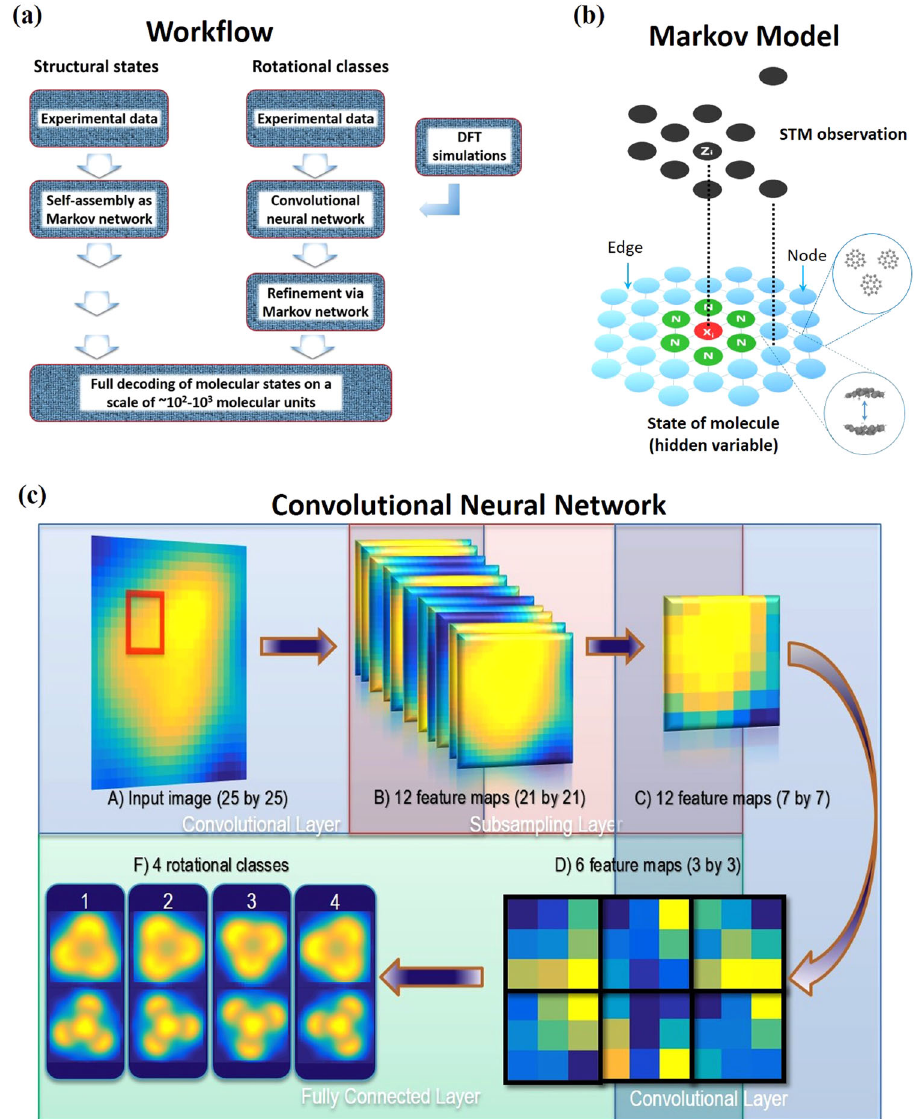
Fig. 2 Work fl ow overview. a Block chart diagram of the work fl ow for classi fi cation of U and D states, and different rotational classes. b Graphical Markov model structure used for analysis of a molecular self-assembly of buckybowls. Here Markov network on a regular lattice acts as a prior over hidden variables (associated with the state of the molecule) in a model which is coupled to an array z of experimental observations (STM signal). c Schematics of convolutional neural network (cNN). The 12 convolutions of a size (21px × 21px) are generated by applying 12 kernels of a size (5px × 5px), with sigmoid activation function, to the input image. The fi lters are shifted across the image with a step size of 1px. These convolutions are subsampled into 12 maps of a size (7px × 7px) using average pooling technique. The second convolution layer is formed by applying 6 kernels, with sigmoid activation function, to an input from the previous layer. At the end of the network, a fully connected layers contains four neurons corresponding to different rotational